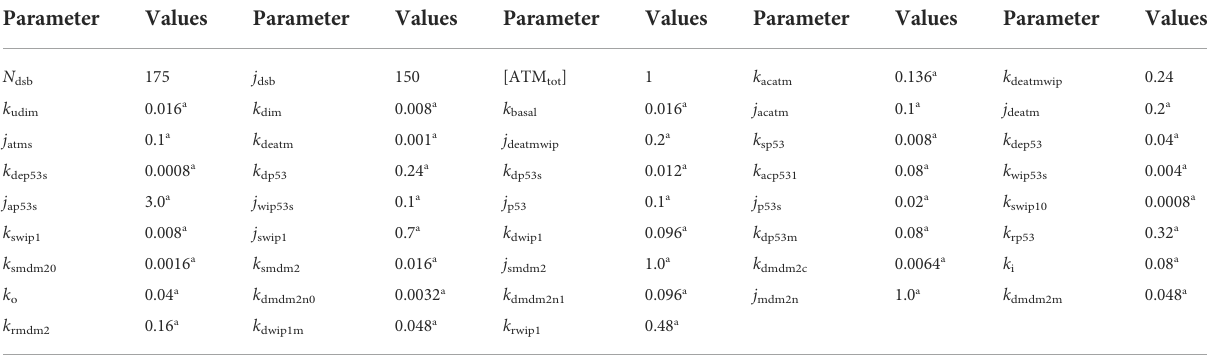
TABLE 1 Default values of parameters. Parameter Values Parameter Values Parameter Values Parameter Values